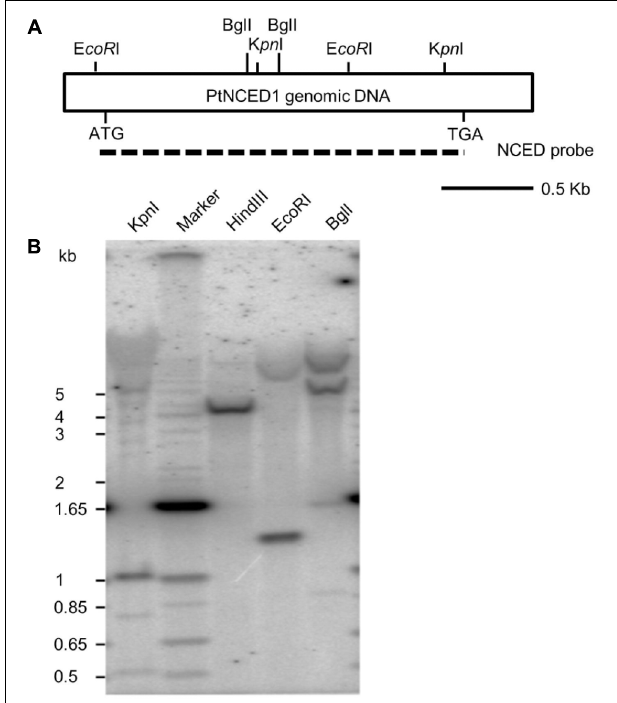
FIGURE 3 | Southern hybridization of the PtNCED1 gene. (A) Schematic depiction of the cDNA fragment of PtNCED1 with Eco RI, Bgl I and Kpn I endonuclease sites shown. Dashed line indicates the open reading frame region used as a probe. (B) Southern blot analysis. Each lane was loaded with 20 µ g genomic DNA from P. tankervilliae digested by the indicated restriction enzyme. The DNA markers are indicated on the